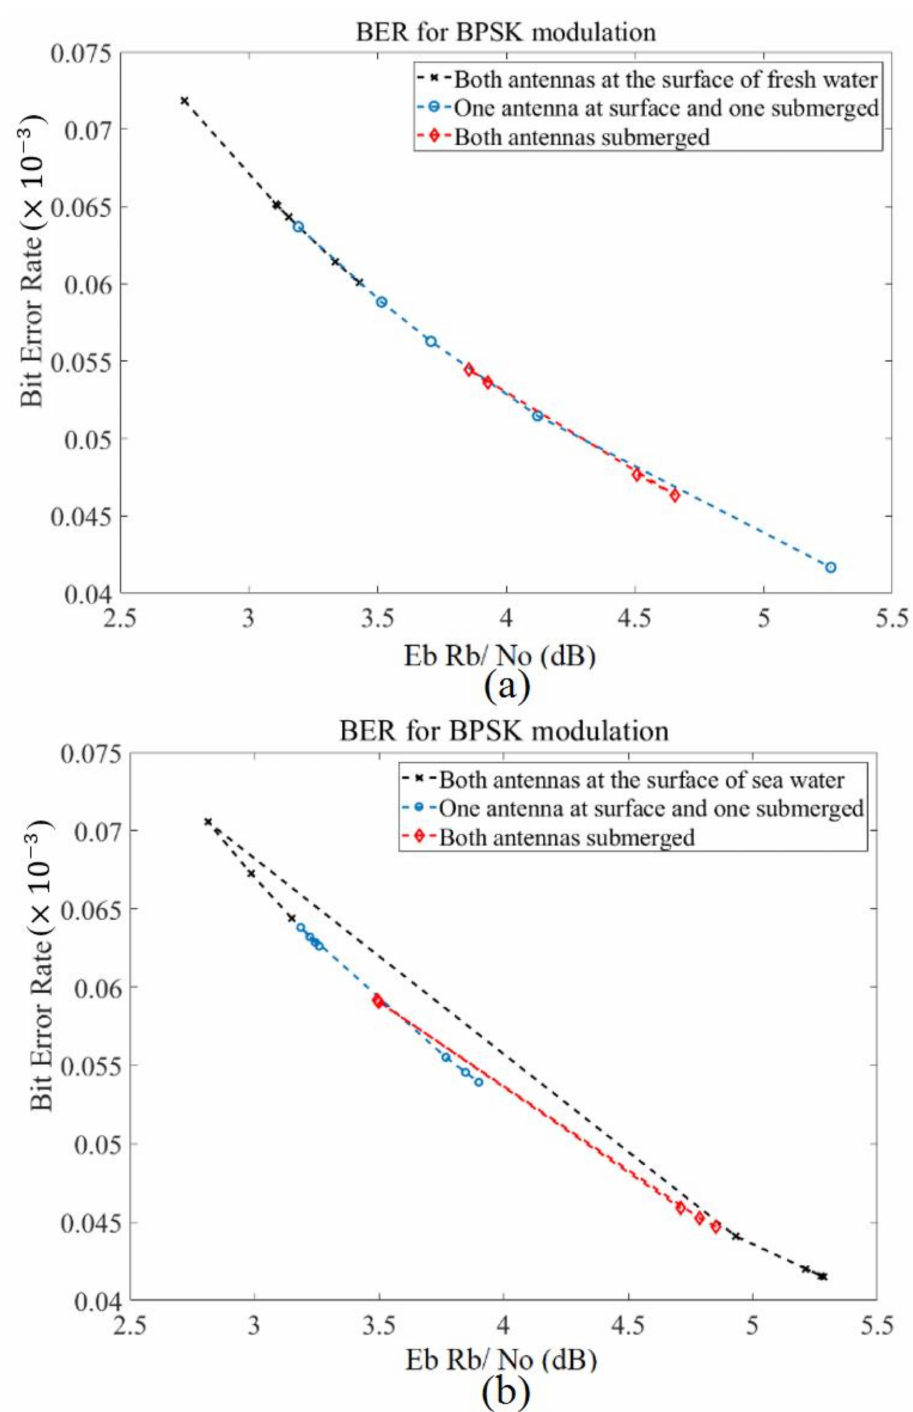
Figure 17. A bit-rate R b average energy per bit E b and noise power density N 0 in terms of BER ( a ) fresh water, and ( b ) sea